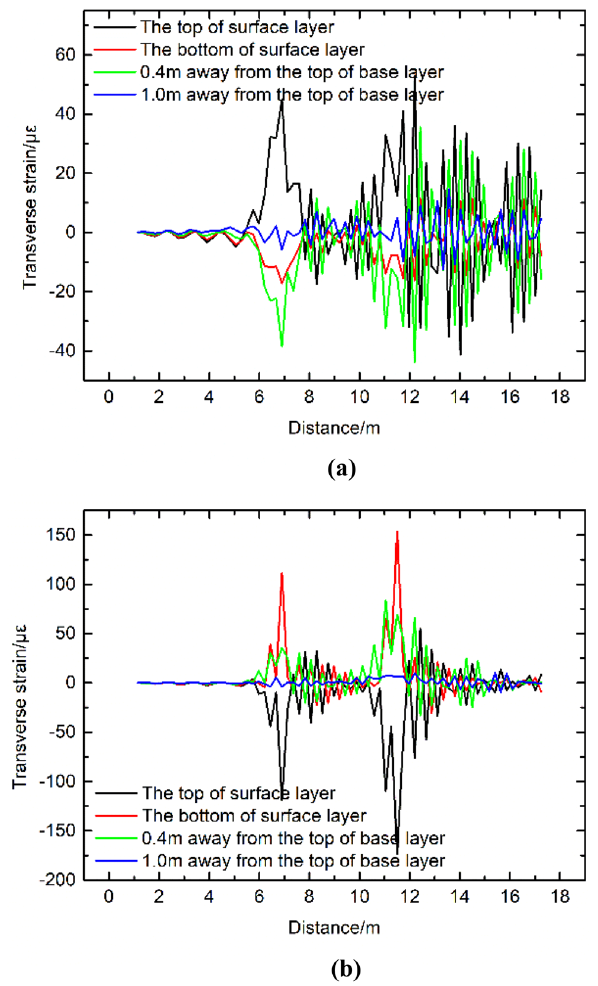
Fig. 5 Transverse strains at a the centerline of the two wheels and b under a single